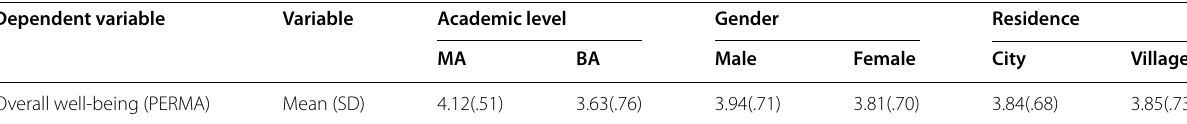
Table 4 Differences in overall well-being by academic level, gender, and residence ( n